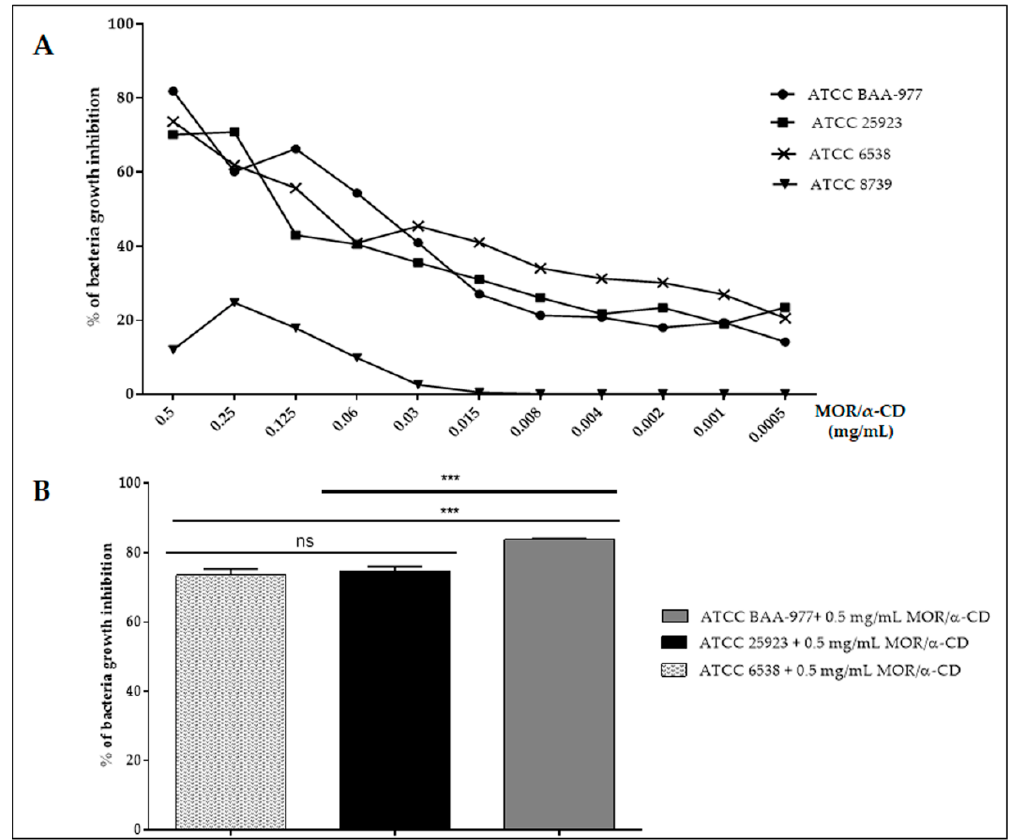
Figure 3. The percentage of relative bacterial growth inhibition among the strains. ( A ) Percentage of bacterial growth inhibition by different doses of MOR/ α -CD complex calculated as [(Ac − At)/Ac] × 100, where Ac was the OD reached by untreated bacteria after 24 h of incubation and At was the OD reached by treated bacteria after 24 h of incubation. ( B ) A statistical analysis (one-way ANOVA test) was performed by GraphPad Prism6 software to compare the most effective dose of the MOR/ α -CD complex (0.5 mg/mL) among the strains. Experiments were assessed in triplicate to obtain the mean and the standard deviation (SD). p value < 0.0002 (***) showed a significant